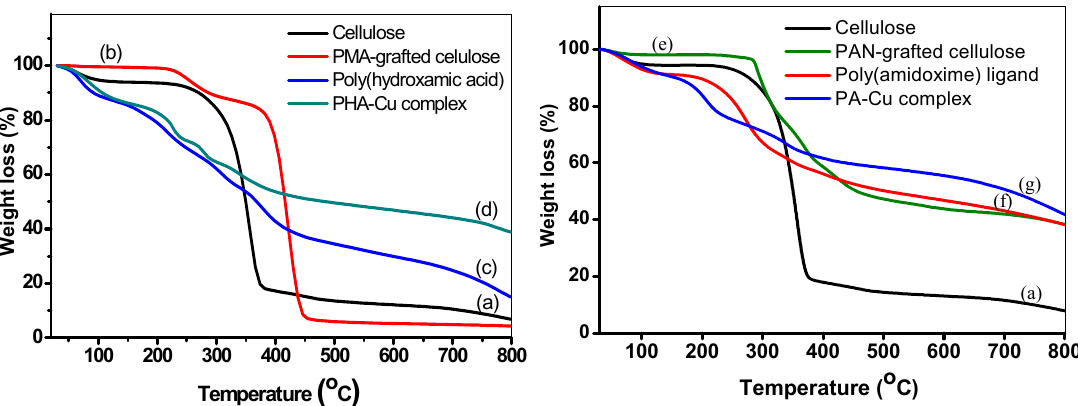
Figure 7. ( left ) Thermogravimetry analysis (TGA) thermograms of cellulose ( a ), PMA-grafted cellulose ( b ), poly(hydroxamic acid) ligand ( c ), PHA-copper complex ( d ) and ( right ) thermograms of cellulose ( a ), PAN-grafted cellulose ( e ), poly(amidoxime) ligand ( f ), PA–copper complex ( g ).